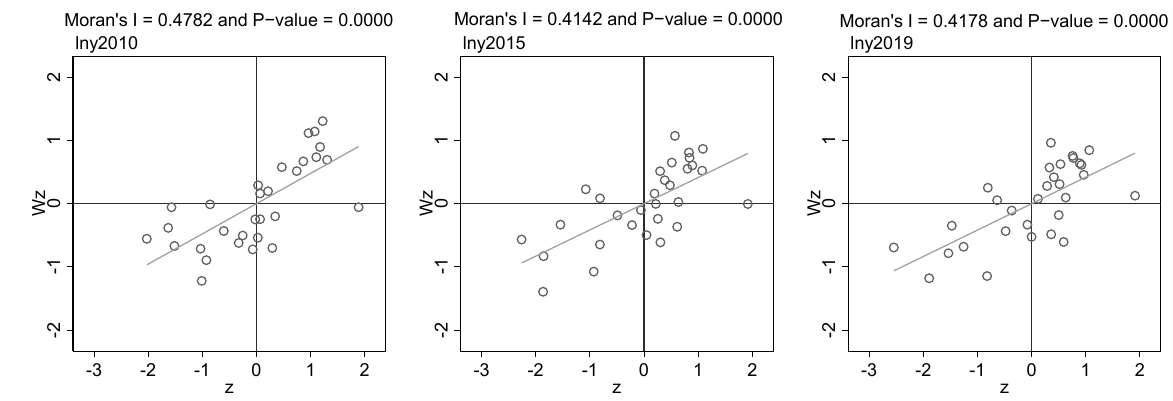
Figure 1. Moran scatter plot of provincial carbon productivity in China.